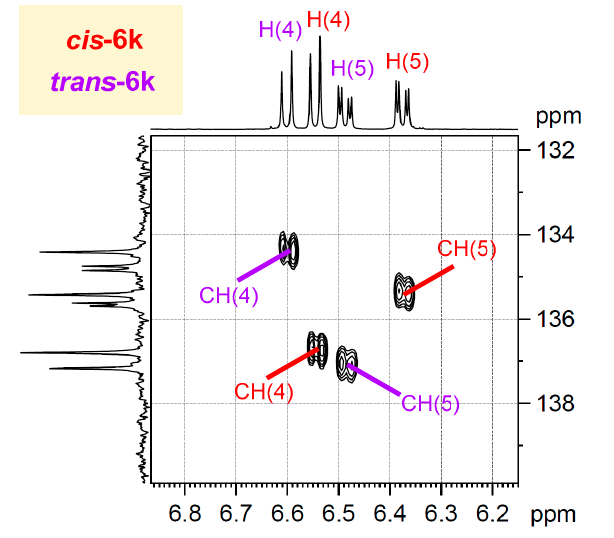
Figure 5. Typical characteristic pattern of CH(4) and CH(5) correlation peaks in 2D HSQC spectra (mixture of trans and cis diastereomers of 6k as an example) used for assignments of diastereomers.